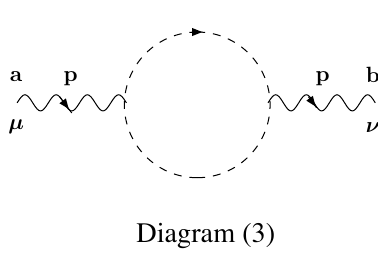
Figure 4 . One-ghost-loop Feynman diagram contributing to the 2-point